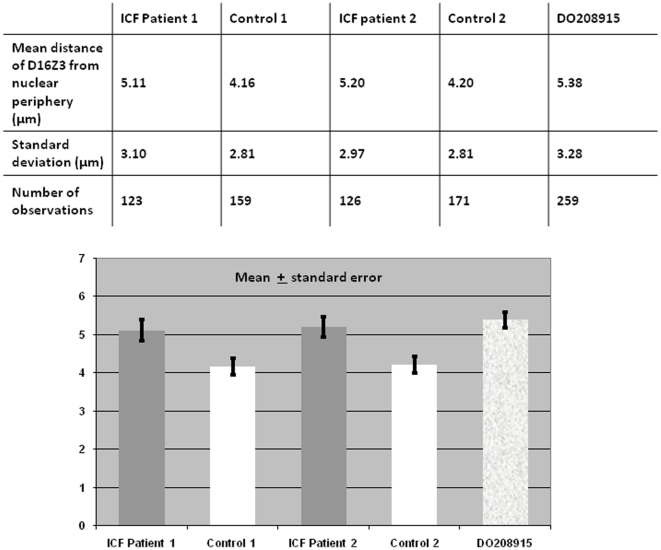
Chromosome 16 juxtacentromeric heterochromatin positioning in relation to the extreme nuclear periphery: distance measurements in ICF cells and controls.The average distance between the centroid of the chromosome 16 juxtacentromeric heterochromatic signal and the extreme nuclear periphery, as defined by the edge of the DAPI nuclear staining, was calculated in unsynchronised B-lymphoblastoid cells from ICF Patients 1 and 2, Controls 1 and 2 and DO208915. In contrast to previous observations, when performing a Kolmogorov-Smirnov test, there is no significant difference in the distance of D16Z3 to the nuclear periphery between ICF and normal cell lines (D = 0.0558, P = 0.678).